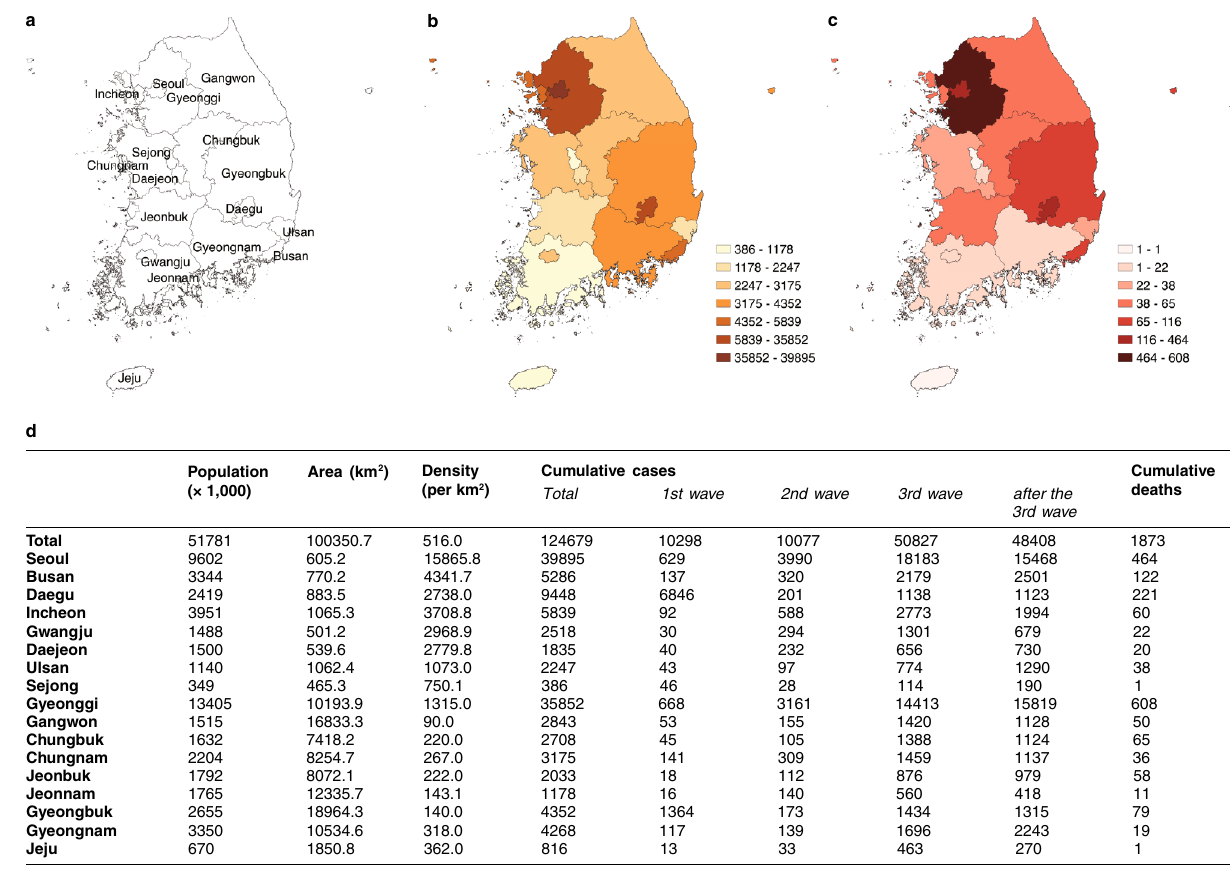
Figure 1. Spatial distribution of the cumulative confirmed and deaths of COVID-19 as of May 10, 2021. ( a ) A map of South Korea. South Korea is divided into 17 first-tier administrative divisions: 7 metropolitan cities (Seoul, Busan, Daegu, Incheon, Gwangju, Daejeon, and Ulsan), 1 special self-governing city (Sejong), and 9 provinces. The metropolitan area refers to Seoul, Incheon, and Gyeonggi. ( b ) Cumulative confirmed cases. ( c ) Cumulative deaths. Geographical descriptions such as population, area, and population density of each region; and COVID-19 profiles are in ( d ). Population density between metropolitan cities and non-metropolitan areas is extremely polarized, except Gyeonggi. The total population of three metropolitan areas is about 26 million as of May 2021, which is more than 50% of the South Korean